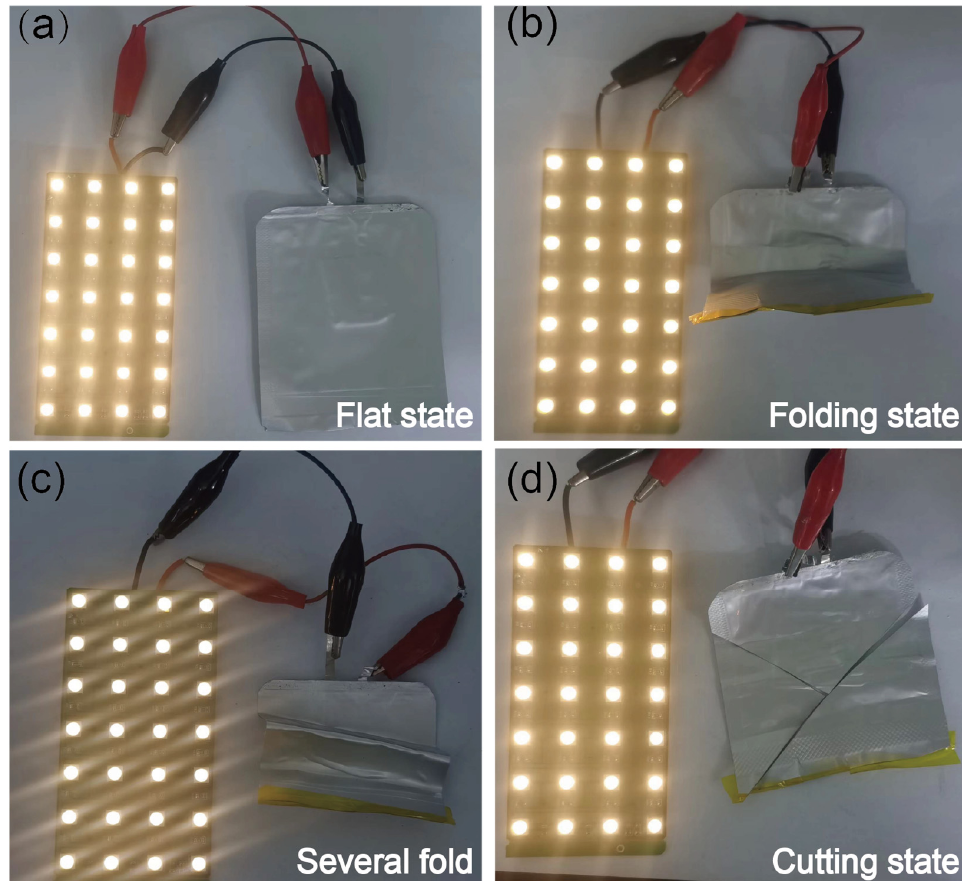
Figure 5. Optical images of the LED lamp powered by the pouch cell in various states: ( a ) flat state; ( b ) folding state; ( c ) several fold; ( d ) cutting state. ( b ) folding state; ( c ) several fold; ( d ) cutting